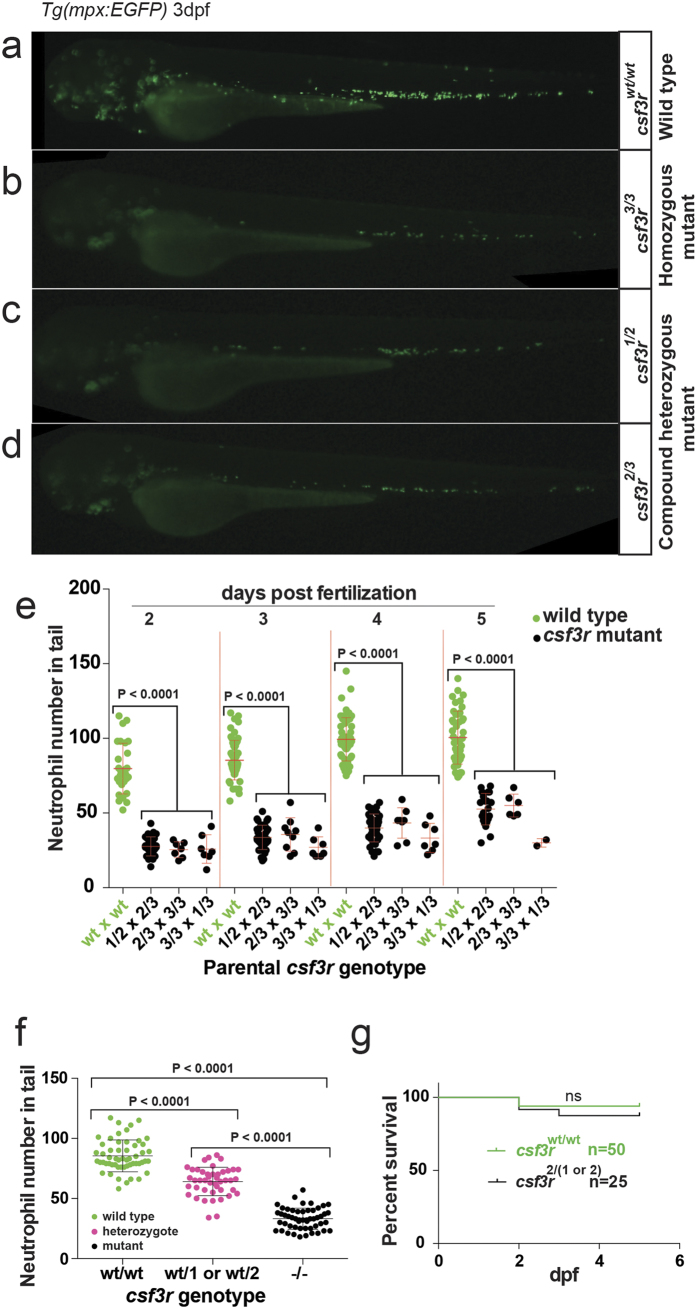
Neutrophil deficiency in csf3r null F2 embryos.(a–d) Fluorescence micrographs of 3 dpf Tg(mpx:EGFP) embryos showing that several representative csf3r mutant null allelotypes (b–d) have substantially reduced numbers of fluorescent neutrophils compared to WT (a). Panel b is a representative homozygous csf3r3/3 null embryo, and panels c-d show representative compound heterozygous null embryos of the two allelotypes shown. (e) Quantification over 2–5 days post-fertilisation (dpf) of tail region neutrophil numbers in embryos of control (WT) matings and incrosses of 3 different pairs of csf3r null parents of the csf3r allelotypes shown. Data are mean ± SD. Within-day comparisons across genotypes are analysed by unpaired two-tailed t-tests, pooling data from the mutant compound heterozygous allelotypes shown, which are not significantly different to each other. These parental allelotype combinations were randomly selected, being those pairs that laid of those that were set up. They are not intended to be comprehensive, but they do demonstrate a consistent non-complementing neutrophil-depletion phenotype encompassing five embryonic allelotypes (1/2, 1/3, 2/2, 2/3 and 3/3). (f) Embryos carrying single csf3r null alleles have an intermediate neutrophil deficiency. A mix of heterozygous csf3rwt/(1or2) embryos in a 1:1 ratio were generated by outcrossing a parent of genotype csf3r1/2 to WT. Their neutrophil numbers at 3 dpf are compared with the non-contemporaneous csf3rWT/WT and pooled csf3r−/− mutant 3 dpf groups of panel (e). The mutant data were pooled as none of the mutant allelotype groups is significantly different to any other. p-values are from one-way ANOVA with Tukey’s multiple comparisons test. p < 0.0001. (g) csf3r null embryos have equivalent survival to WT embryos up to 5 days post-fertilisation (dpf). Kaplan-Meier plots compared by Wilcoxon rank sum test.